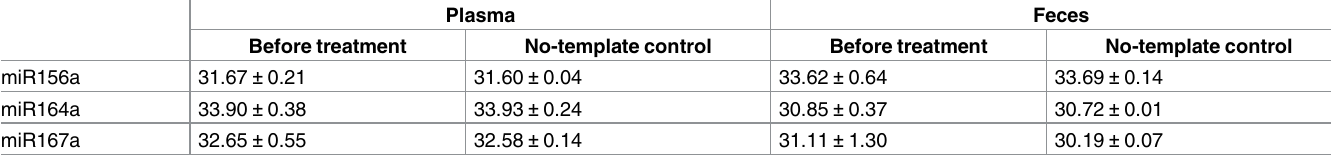
Table 4. Plasma and fecal miRNA amplification cycle numbers.